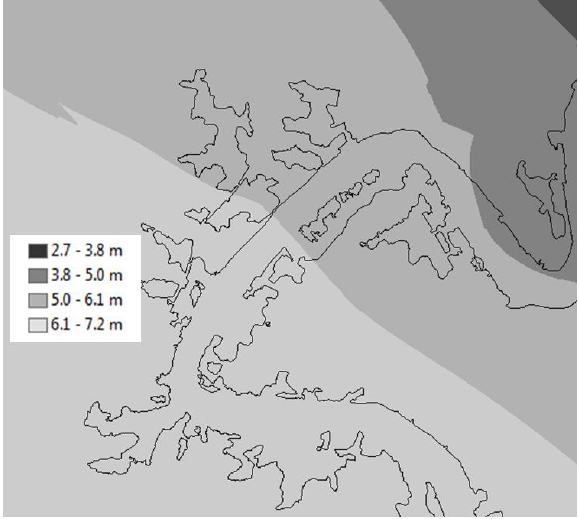
Figure 8. Depth of inundation in 1 m